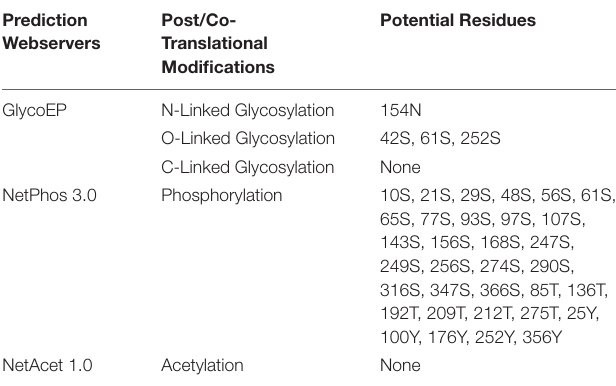
TABLE 2 | Potential residues predicted in 3p.AtFBP113 protein sequence to undergo post/co-translational modifications. Prediction